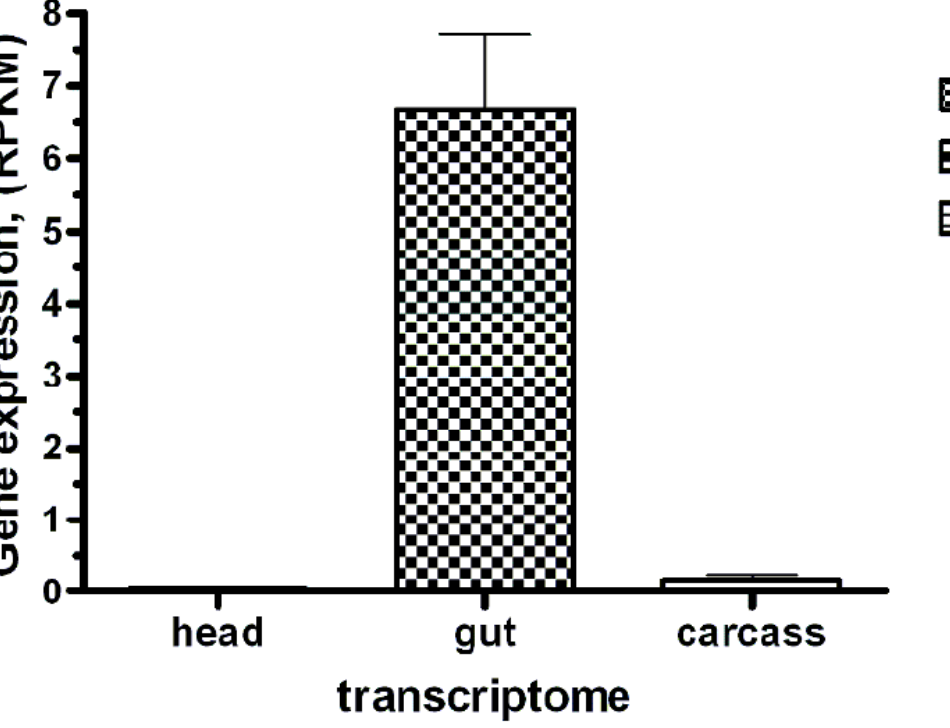
Figure 9. The Bt-R1-like cadherin-specific transcript abundance in the R. dominica larvae transcrip- tomes (head, gut, and carcass). Sequence reads obtained after Ion Torrent sequencing were mapped to the open reading frame of the putative cadherin identified by similarity with several previously studied “reference” insect Bt toxin receptor cadherins. The mapped read counts were normalized by Reads Per Kilobase of template per Million mapped reads (RPKM, ± SE, n = 3). TBRs from M. sexta BtR1 cadherin were used to identify RdCad1 TBR1 (amino